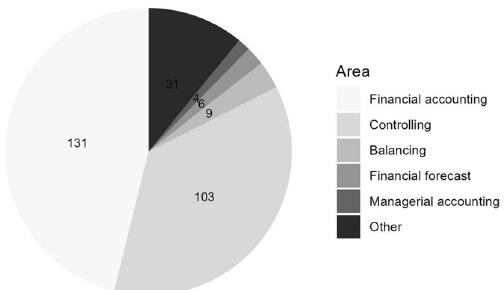
Fig. 7 Areas of activities in accounting